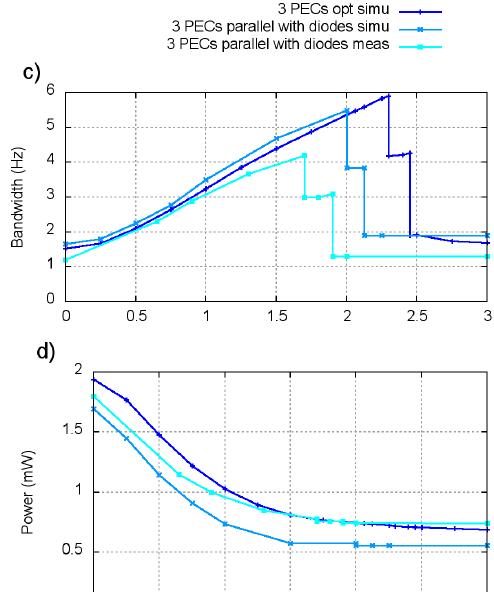
Figure 15. Comparison of the simulated and measured power with dependence upon frequency for the parallel connection of three PECs with individual rectifiers and ∆ f = 1.5 Hz ( left ) or ∆ f = 2 Hz ( right ). As explained in [19], the disadvantage of a PEC array design with frequency-detuned cantilevers based on the overall electrical rectification is the inevitable charge cancellation causing lower power output. In the present paper, we considered the respective electrical rectification of individual PEC outputs. In the considered experimental situation, such an approach seems to pay off with respect to the achieved frequency bandwidth and guaranteed output power. Obviously, the complexity of the electronic circuitry is somewhat increased in comparison to the overall electrical rectification due to the presence of additional rectifiers. The discrepancies between the simulation results and the experiments are obviously explained by the imperfection of the model. One reason for these differences is the non-linear behavior of cantilevers. The resonance curve is noticeably asymmetric with respect to the resonance frequency, which can be attributed to the softening behavior of the cantilever [28]. Although the bandwidth can be reproduced sufficiently well with the simplifying approach of Section 2, the course of frequency dependencies between the half-power-frequencies for measurements and simulations is different. Therefore, the nonlinearity of the cantilevers should be considered in the future simulations, in order to achieve better agreement. Furthermore, some differences can be seen in the voltage amplitudes of the individual PECs. We attribute these differences to the additional mechanical coupling the cantilevers through the base plate where they are fixed. The model should be extended to include the coupling through the base plate into the simulations in order to achieve a better accuracy. However, it is observed that even a simplified model such as that presented in this paper is useful since it provides reasonable agreement with experiments and allows one to understand the basic regularities of vibration energy harvesting with tip-mass tuned PECs. We believe that general conclusions derived in this paper (in particular, in Section 3.2) are generally valid. However, there may be refinements necessary as far